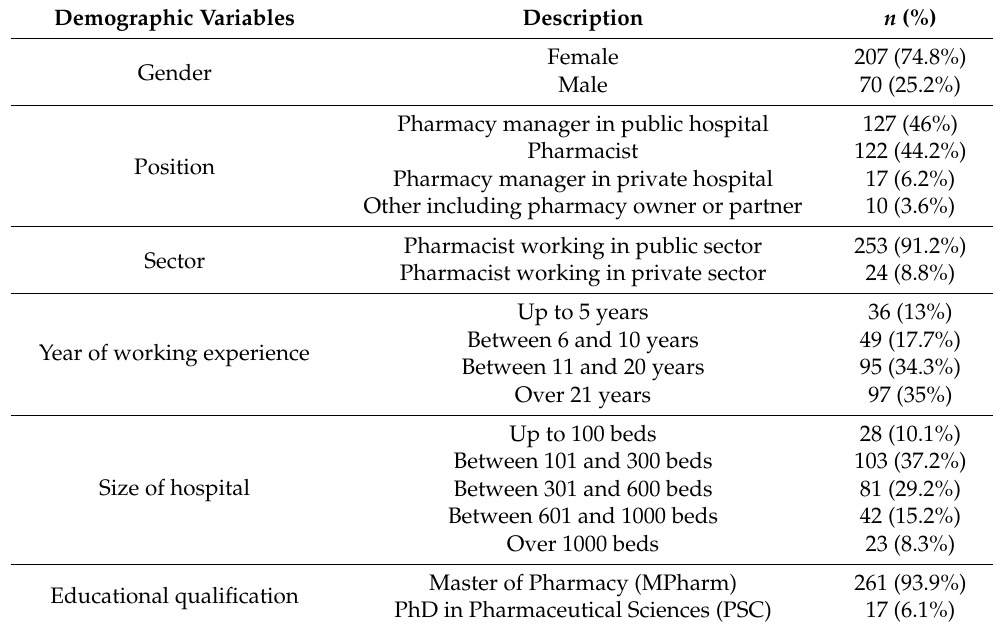
Table 1. Demographic characteristics of participants ( n =